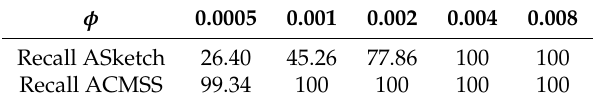
Table 5. Recall, zipfian distribution with skew ρ = 1.3 and budgeted memory equal to 16.25